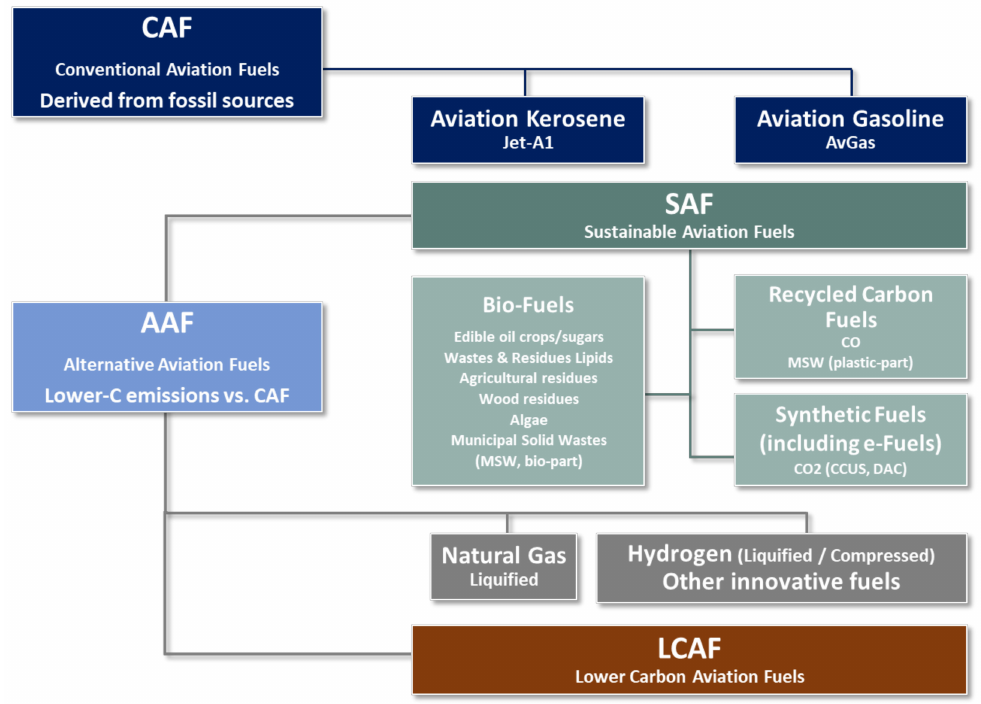
Figure 1. Aviation fuels classification on the basis of the CORSIA Eligible Fuels (adopted from the ICAO CORSIA